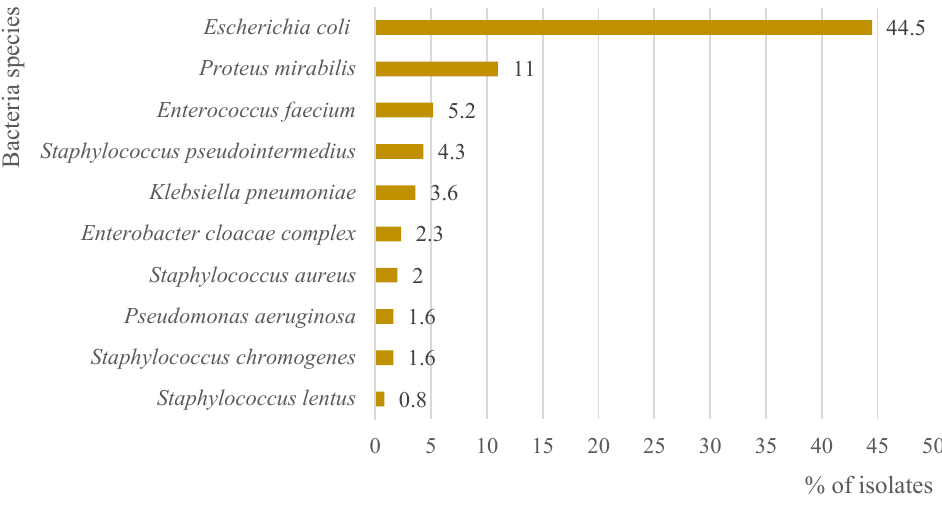
Figure 2. Bacteria species that predominate in the 5306 isolates with positive culture grown from urine samples from dogs and cats submitted to the INNO veterinary laboratory between 2017 and 2021.